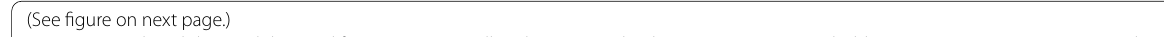
blot and qRT-PCR ( P < 0.05) (Figs. 2A, B, and 3A, B). WB analysis showed that TOP2A expression in the sh- TOP2A group decreased by 92.3% compared with that in the sh-NC group ( P < 0.001), which was consistent with qRT-PCR analysis (FC 0.567) ( P < 0.05). Additionally, = TOP2A protein levels in Htr8 cells in the OE-TOP2A group was 1.3 times higher than that in the vector group, which was consistent with the results of qRT-PCR (FC 1.25) ( P < 0.05). In terms of proliferation, EDU, =